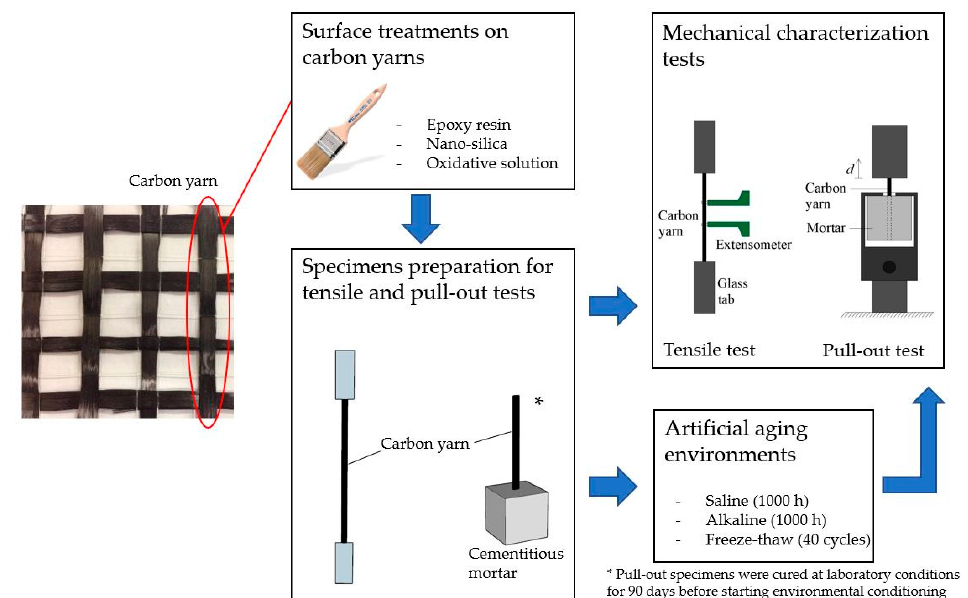
Figure 1. Schematic representation of the experimental campaign.